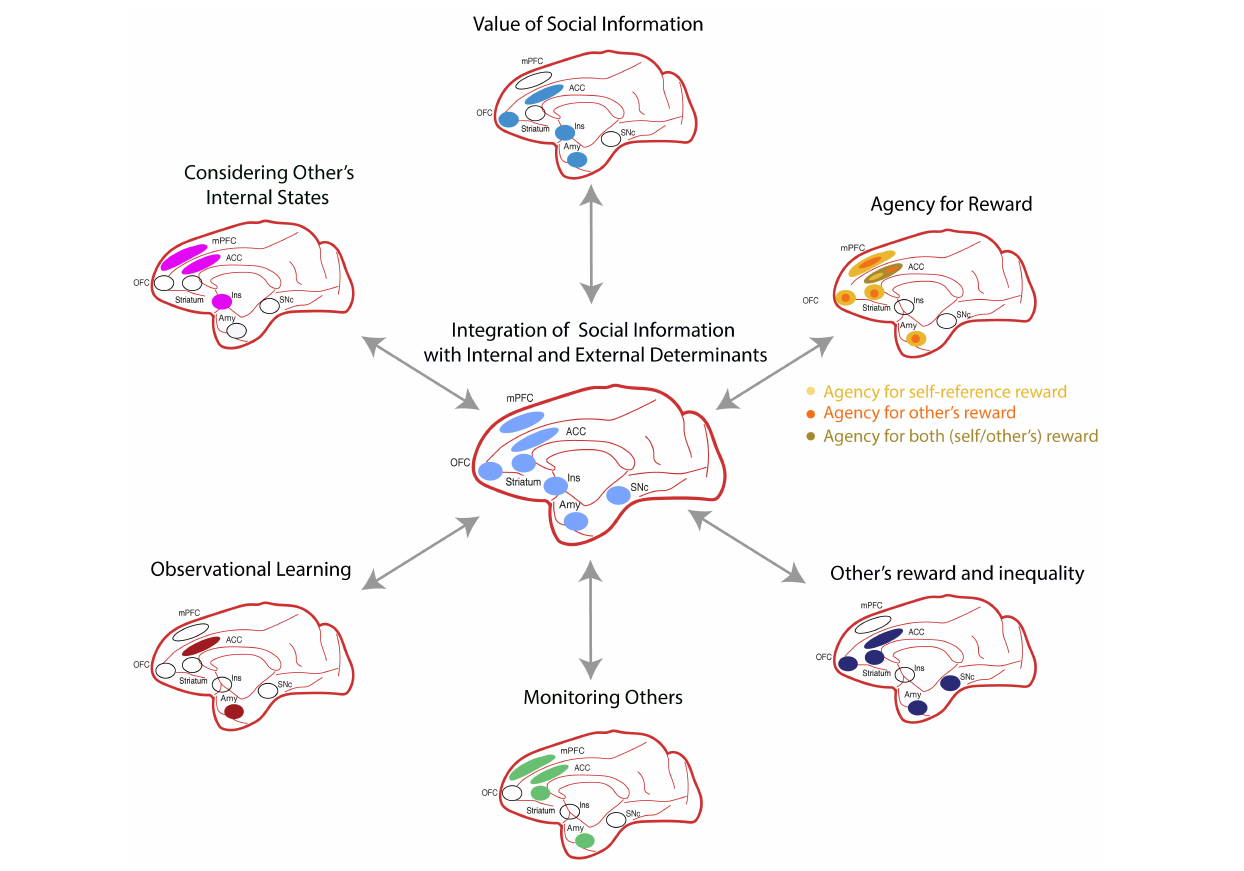
FIGURE 3 | The social valuation network comprises several cortical areas, including: the anterior cingulate cortex (ACC), medial prefrontal cortex (mPFC), medial orbitofrontal cortex (OFC), insula (Ins); and subcortical nuclei including: the anterior striatum, amygdala (Amy), and substantia nigra pars compacta (SNc). Each one of these regions plays a specialized role during distinct cognitive processes of social decision making. Bidirectional arrows indicate the interdependence of these processes on social decisions. All brain regions are illustrated on a sagittal view of a Rhesus brain.